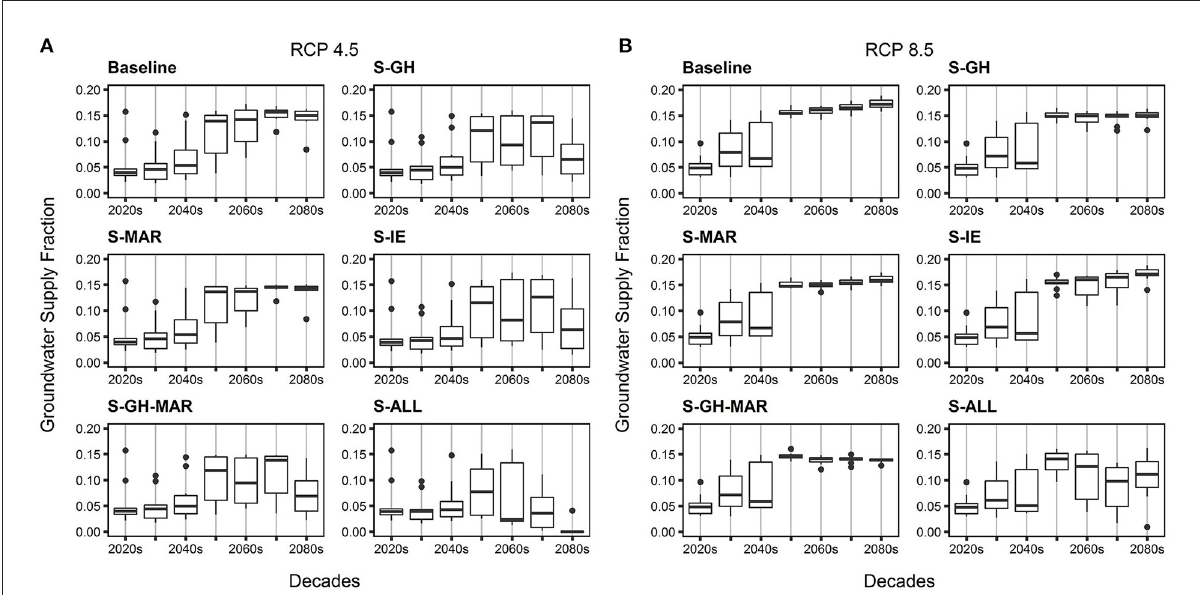
FIGURE13 Ground water fraction for scenarios adopting individual method and combined methods under (A) RCP 4.5 and (B) RCP